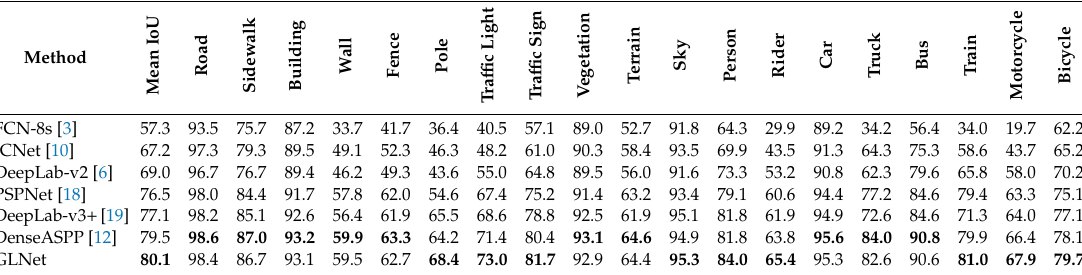
Table 5. Performance comparison on Cityscapes val